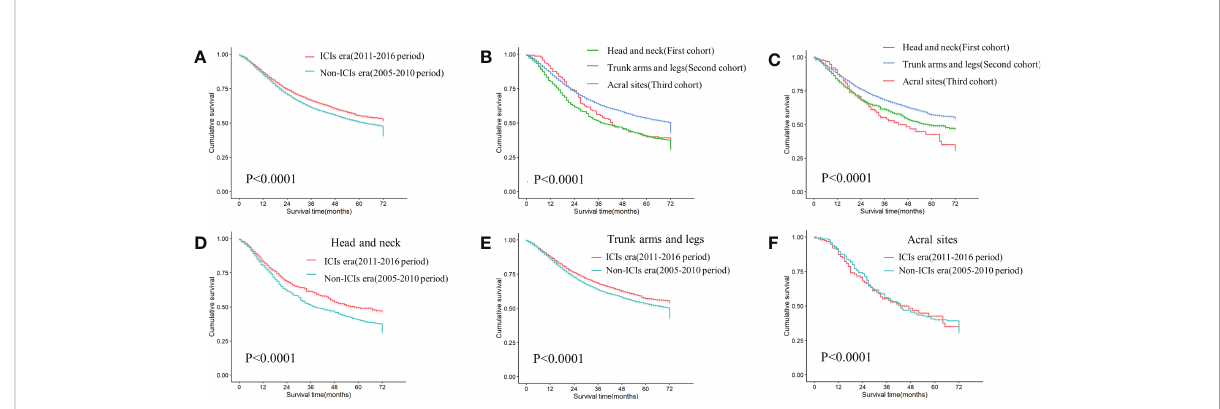
FIGURE 2 KM curves of differences in survival among cohorts (A) Comparing survival differences between non-ICIs era and ICIs era (P<0.0001). (B) Differences in survival among three cohorts in the non-ICIs era (P<0.0001). (C) Differences in survival among three cohorts in the ICIs era (P<0.0001). (D) Differences in survival between the non-ICIs era and the ICIs era in the fi rst cohort (P=0.00011). (E) Differences in survival between the non-ICIs era and the ICIs era in the second cohort (P<0.0001). (F) Differences in survival between the non-ICIs era and the ICIs era in the third cohort (P=0.78).